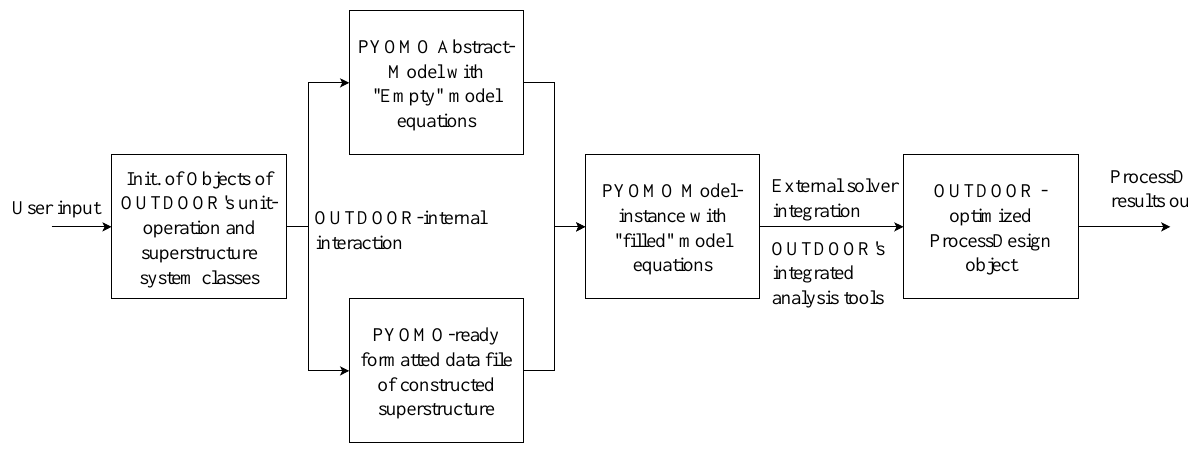
Figure 9. Superstructure modeling and optimization algorithm implemented in OUTDOOR.